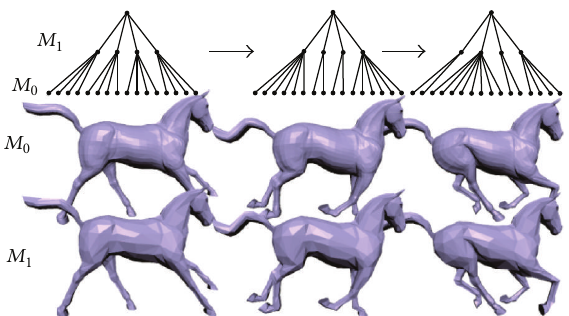
Figure 4: Multiresolution representation proposed by Kircher and Garland